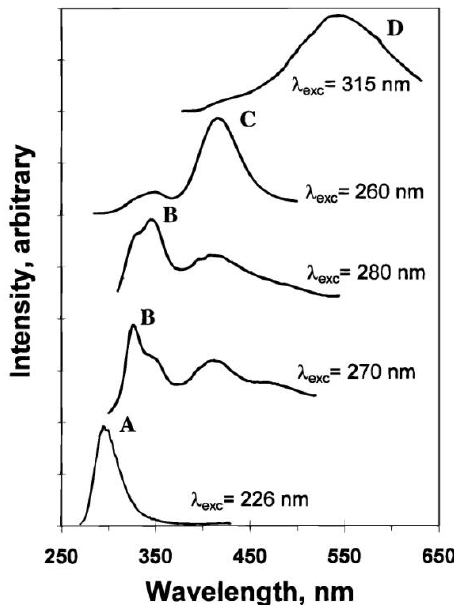
Figure 1. Exciplex tuning by site-selective excitation: emission spectra of a KAg(CN) /KCl crystal at 77 K with different excitation wavelengths. Intensities are not 2 comparable between different spectra. (Reprinted with permission from [31]. Copyright 1998 American Chemical